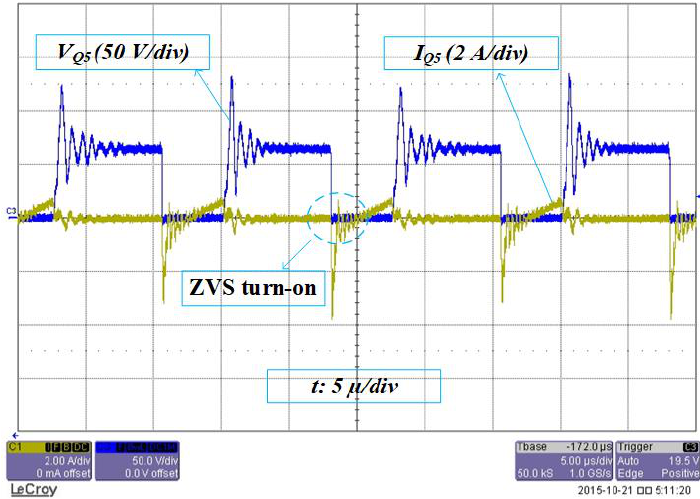
Figure 17. Voltage and current of switch 𝑄 5 at 100% of load.